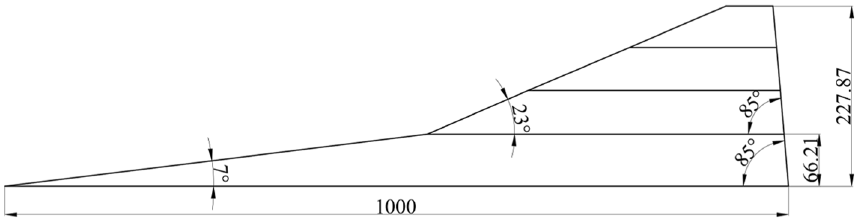
Fig. 8 Schematic of parameterization for the planar shape of the Sanger aerospace plane carrier